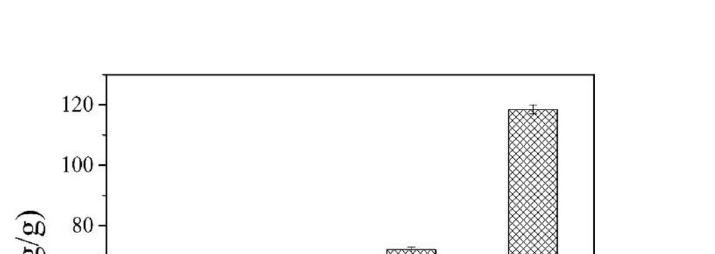
Table 1. The physicochemical properties of RBC, KMBC and different proportions of HAs/KMBC. V tot is total pore volume; D p is average pore diameter.